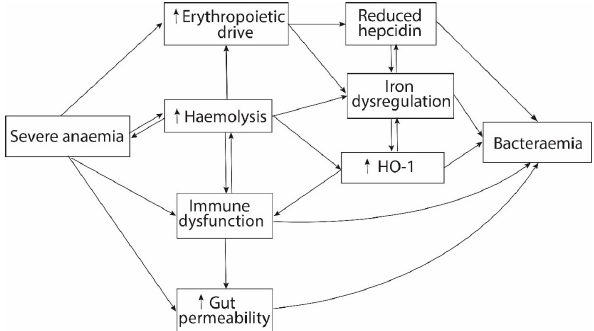
Figure 1. The link between severe anaemia and bacteraemia. Severe anaemia may increase the risk of invasive bacterial infections through several interlinking pathways including increased erythropoietic drive, haemolysis, immune dysfunction, and gut permeability. In both haemolytic and non-haemolytic severe anaemia, elevated erythropoietic drive increases erythroferrone levels, reducing hepcidin, and altering macrophage iron sequestration. This increases iron availability for invading bacterial pathogens. Haemolysis increases the levels of non-transferrin-bound iron, free haem, and haem oxygenase-1 (HO-1), which are associated with immune dysfunction and dysregulation of iron